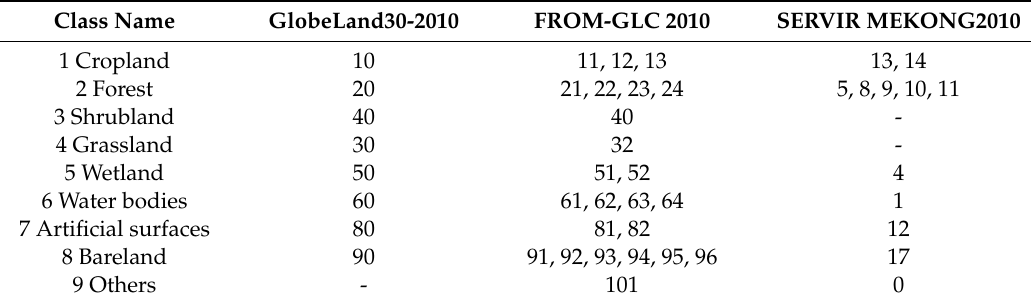
Table 3. Types of land cover included in the study